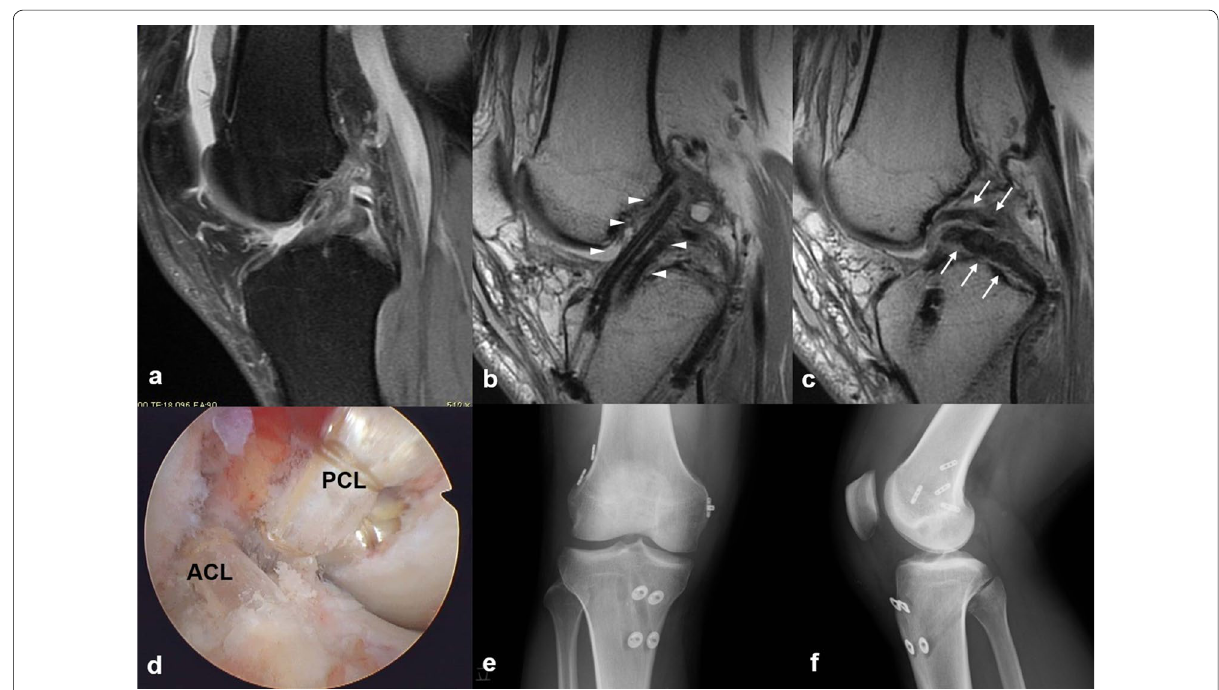
Fig. 5 Double-bundle ACL and PCL reconstructions of right knee (26-year-old male judoist). a preoperative MRI showing torn ACL and PCL; b , c postoperative MRI showing reconstructed ACL (arrow heads) and PCL (arrows), d arthroscopic view of double-bundle ACL and PCL reconstructions, and e , f postoperative radiograph. ACL: anterior cruciate ligament; PCL: posterior cruciate ligament; MRI: magnetic resonance